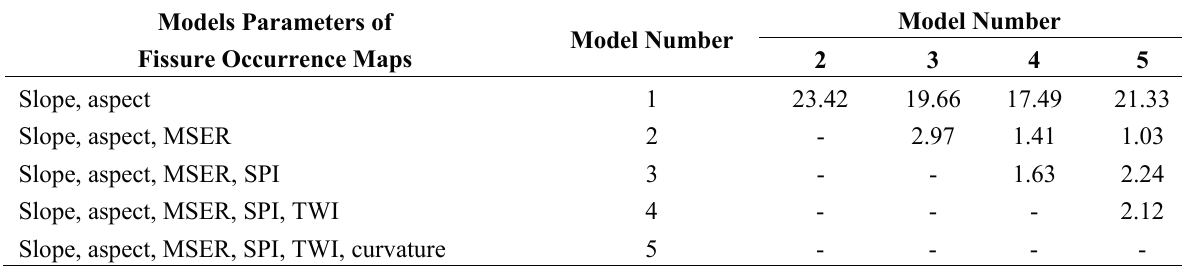
Table 9. Results of McNemar’s tests calculated with the LR fissure occurrence